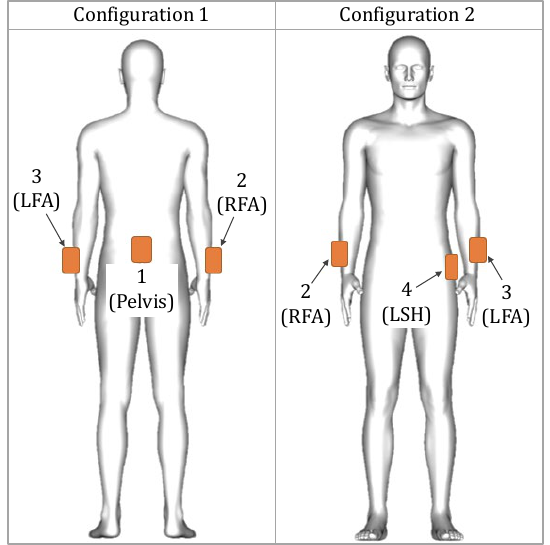
Figure 9. Diagram of the two different possible sensor configurations explored in this paper. Both of them have wrist-mounted sensors in the same locations. On the left, Configuration 1 has the pelvis sensor at the person’s back, which is coincident with the XSens system pelvis sensor. On the right, Configuration 2 has the pelvis sensor at the person’s left hip. LFA = left forearm, RFA = right forearm, SH = left side of